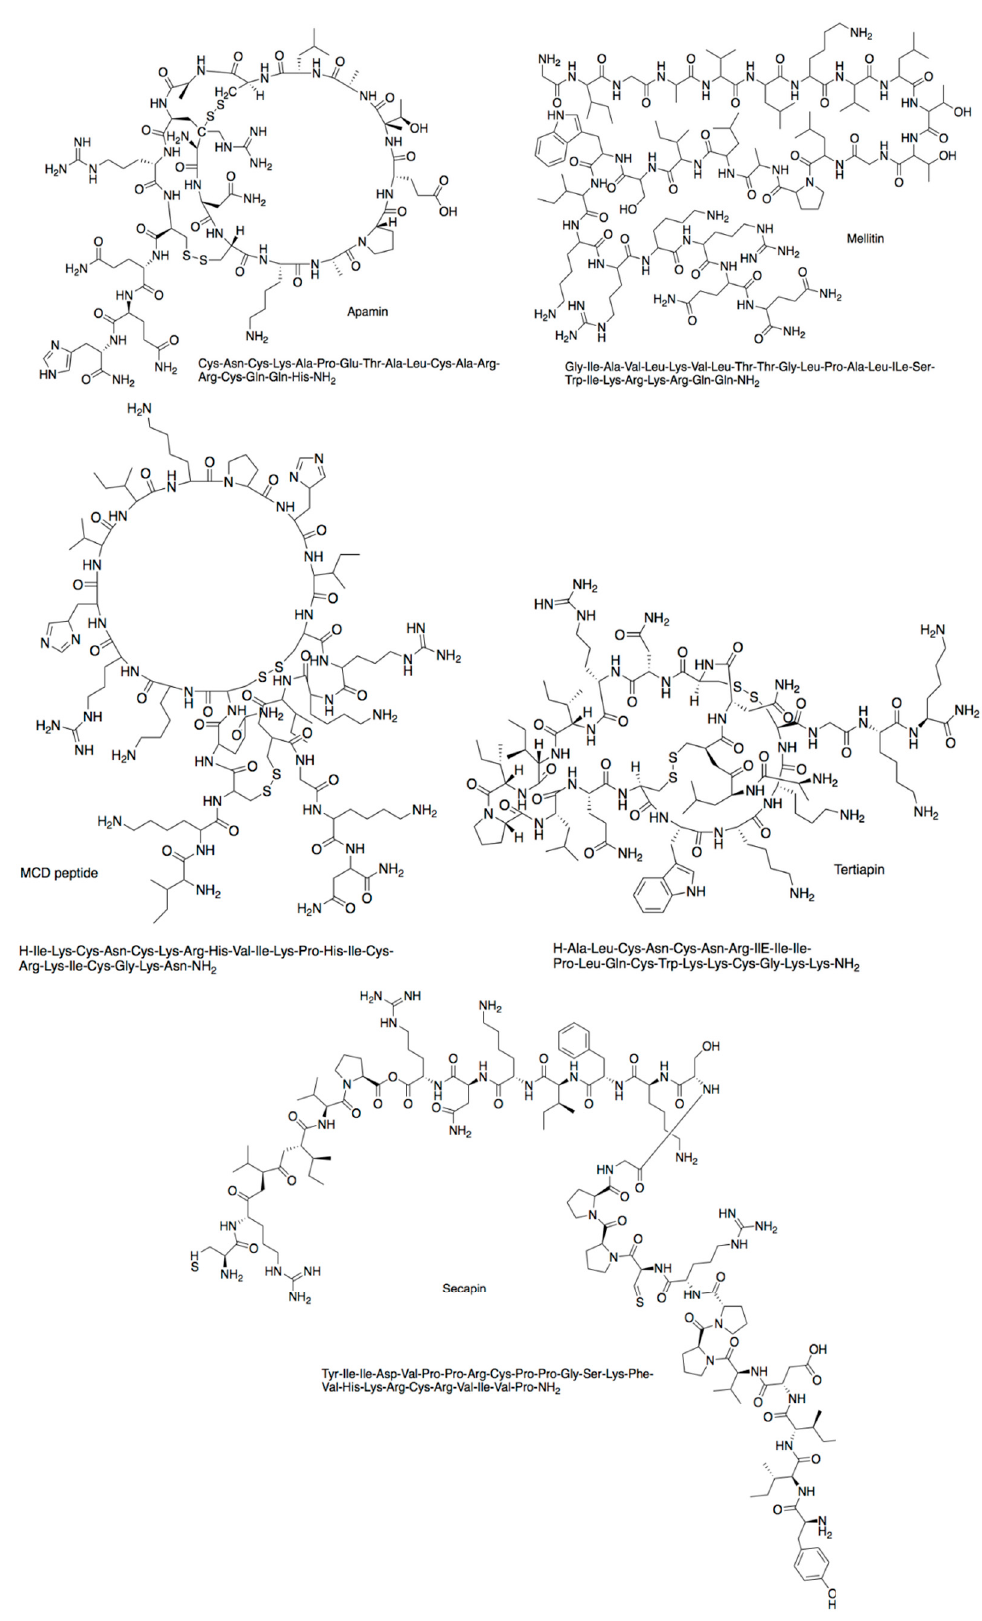
Figure 11. Chemical structures of peptides found in bee venom.